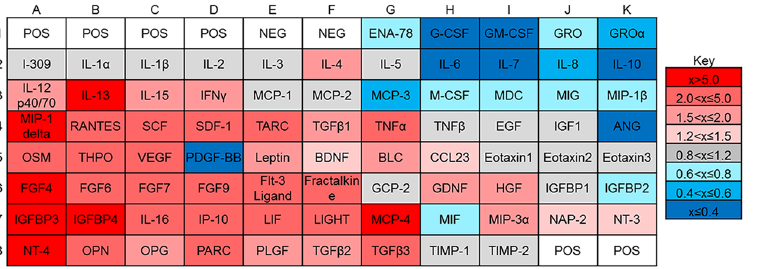
Figure 7. Protein expression is dependent on the concentration of HUVECs in culture. Protein expression of low density HUVEC monocultures (1,000 cell/cm 2 ) were normalized against high density HUVEC monocultures (10,000 cell/cm 2 ). In all cases, red indicates overexpression of indicated proteins and blue indicates underexpression of indicated proteins, with gradations of each color indicating relative amount of over/under expression. POS and NEG wells are internal controls within the cytokine array